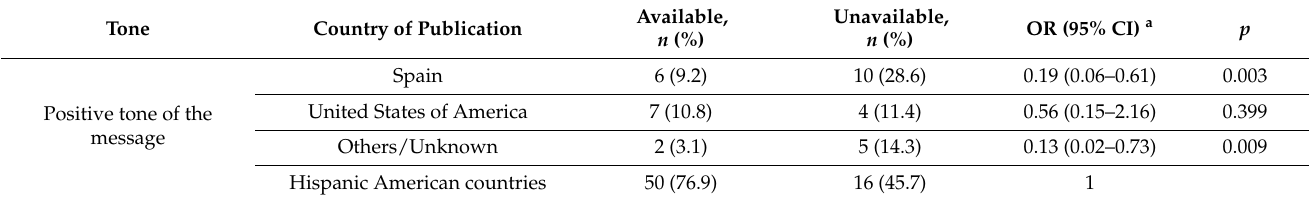
Table 7. Country of publication and tone of the message.